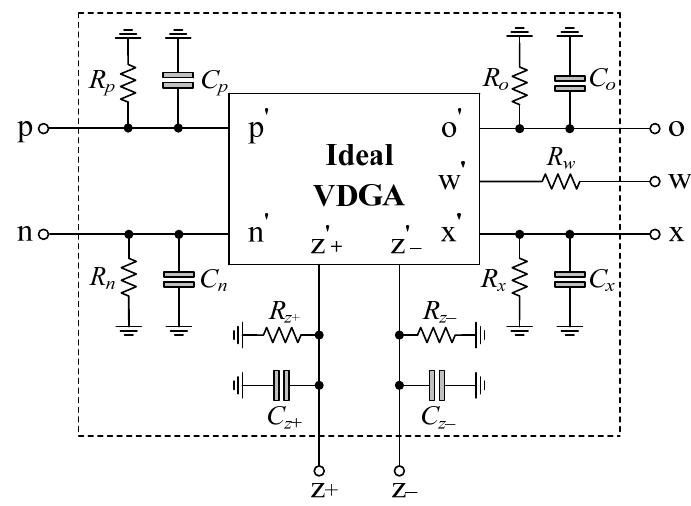
Figure 5. Non-ideal behavior model of the VDGA.